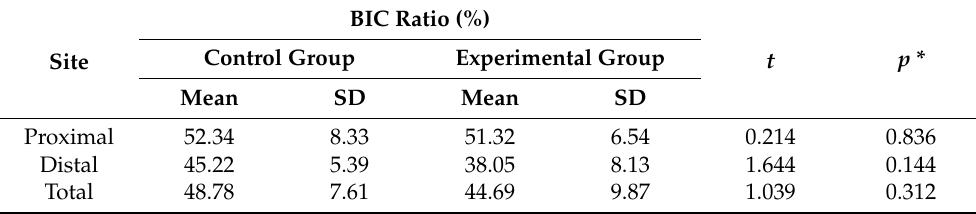
Table 2. Comparison of the bone-to-implant contact (BIC) ratio (%) between the experimental and control groups.